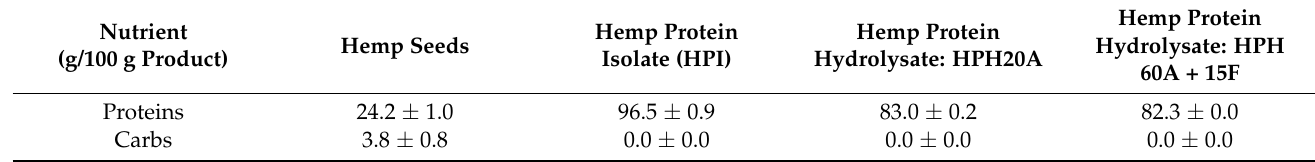
Table A1. Chemical composition of hemp seeds, HPI, HPH20A, and HPH60A15F. Data, expressed as percentage in dry basis, are mean ± standard deviation of